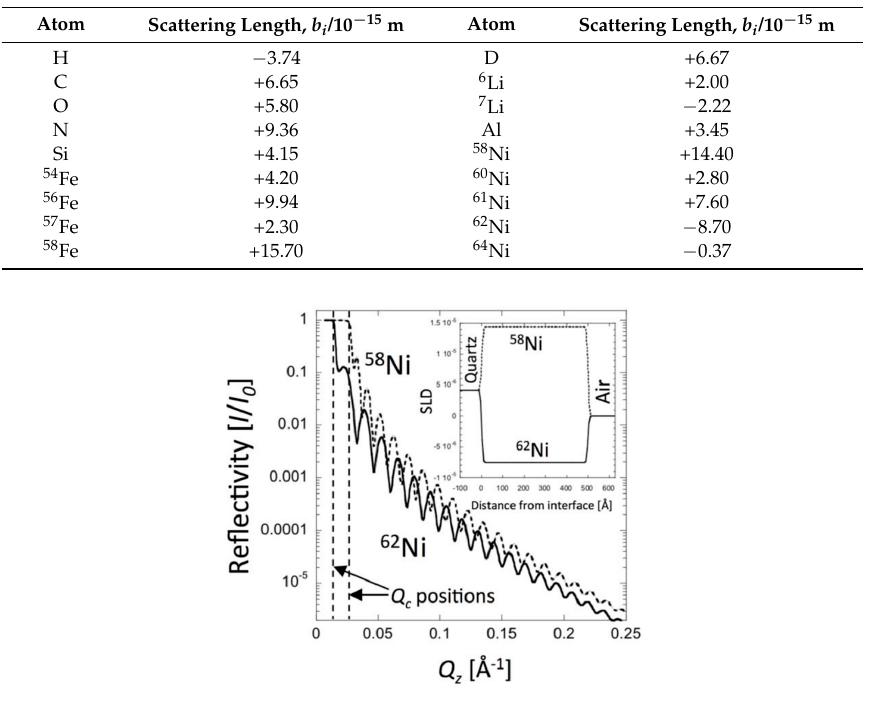
Figure 3. Simulated reflectivity curves for 500 Å films of 58 Ni (dashed line) and 62 Ni (solid line) on a quartz substrate, with scattering length density (SLD) profiles shown in the inset. Reproduced with kind permission from [46], MDPI, 2016.